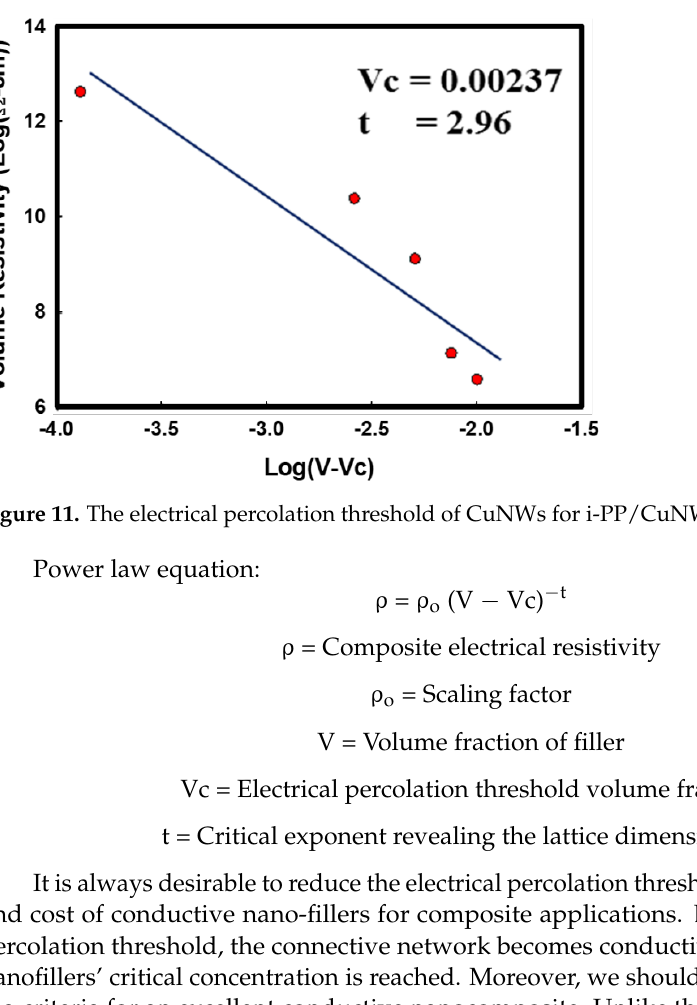
Figure 10. The CuNWs content is dependence on the volume resistivity for various i-PP/CuNWs composites.